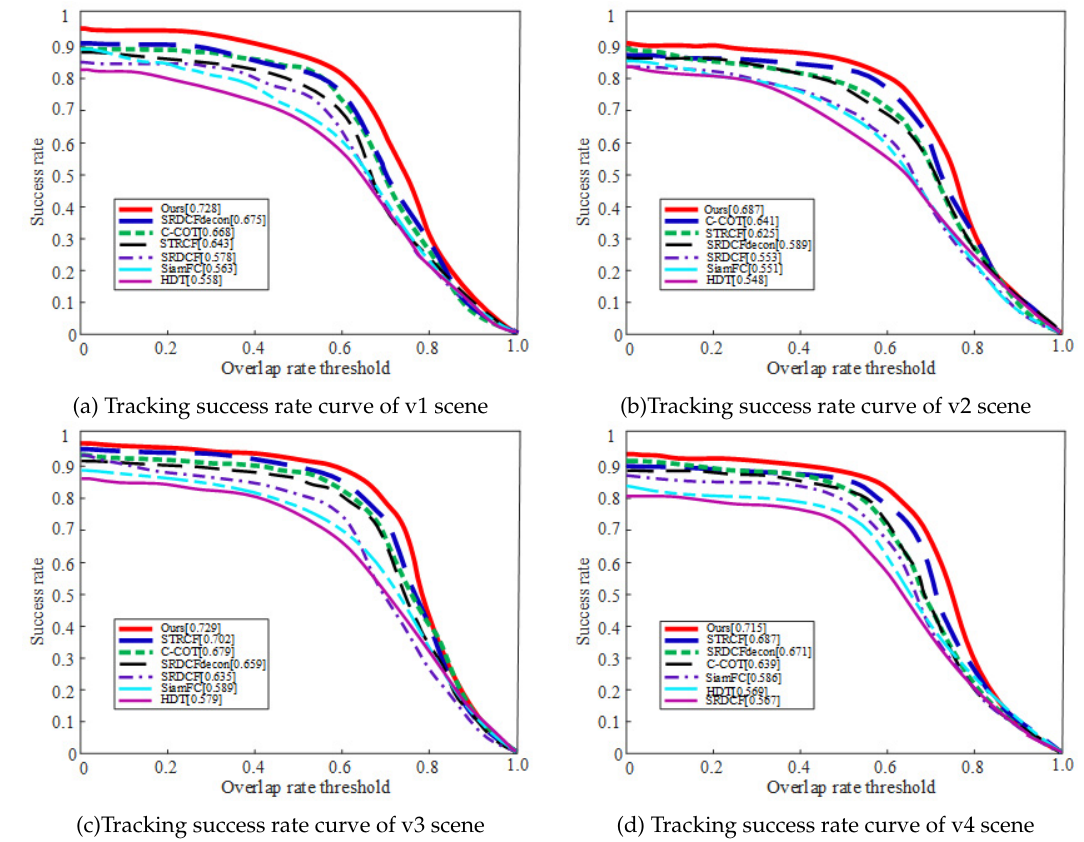
Fig. 4. Comparison curve of the success rate of different algorithms in v1 ∼ v4